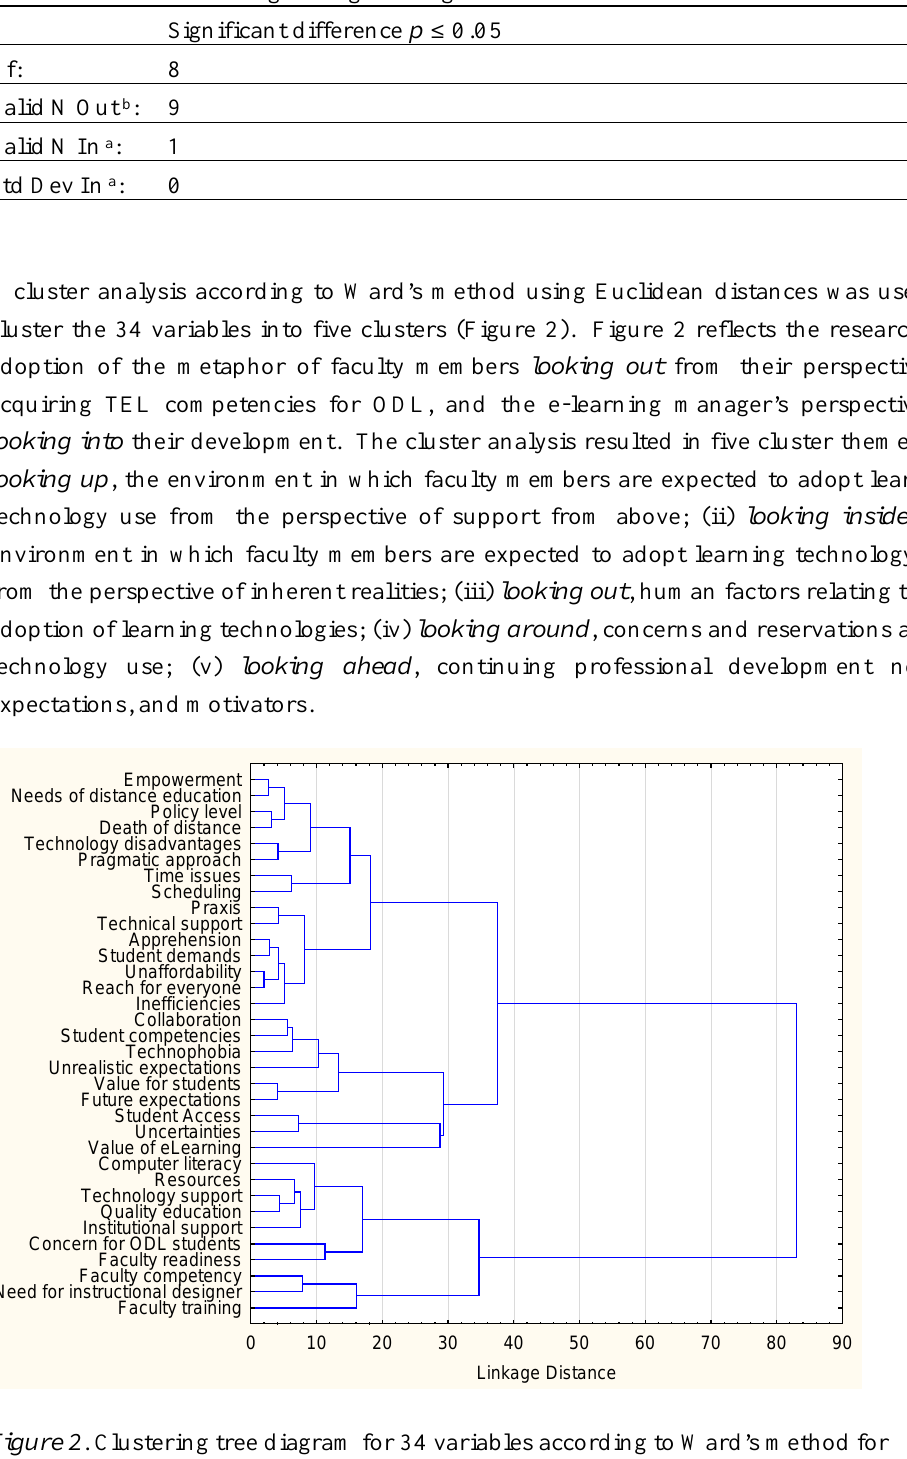
Figure 2 . Clustering tree diagram for 34 variables according to Ward’s method for Euclidean